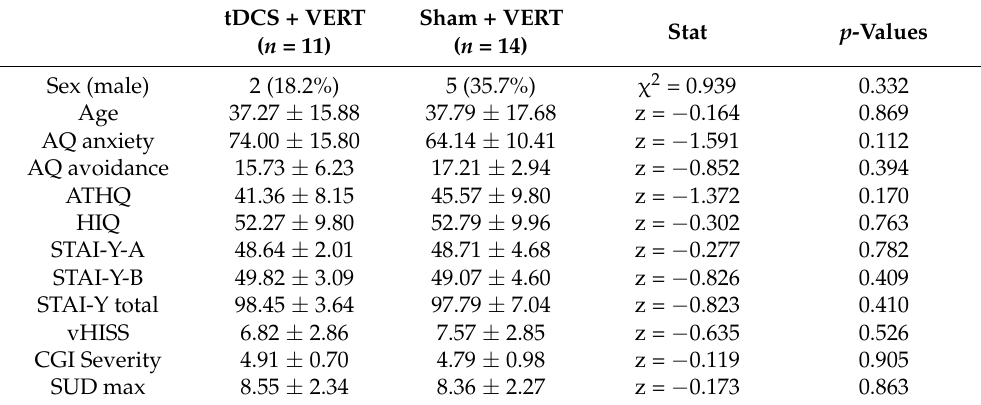
Table 1. Socio-demographic and clinical characteristics of study sample at the baseline